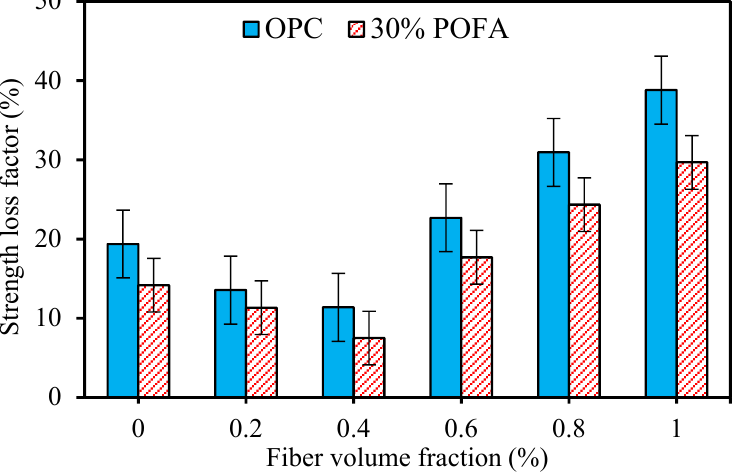
Figure 9. The effects of WPFT fibers on the strength loss factor of concrete exposed to a MgSO 4 solution.